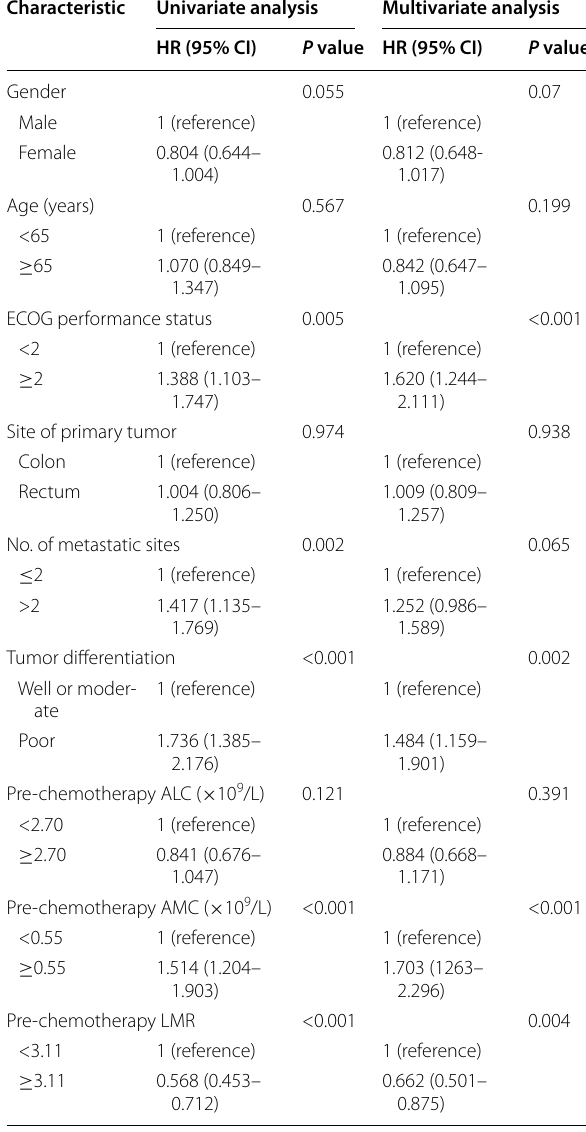
Table 3 Univariate and multivariate analyses of variables associated with overall survival of patients with newly diagnosed metastatic colorectal